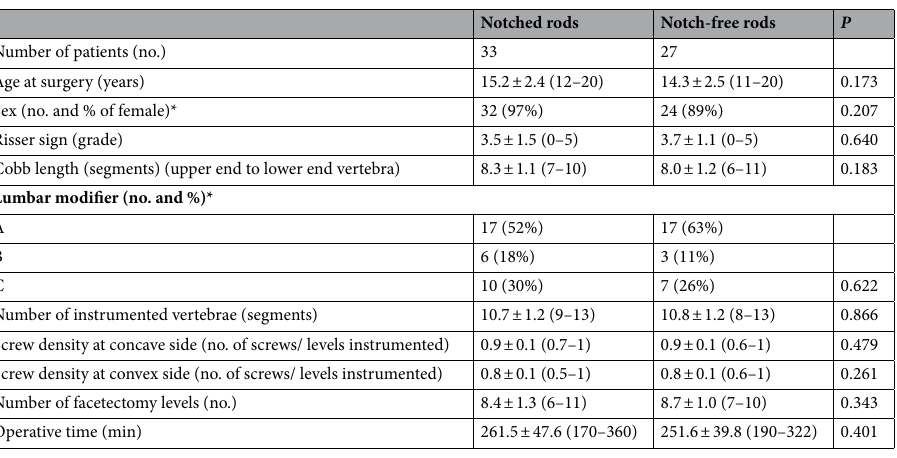
Table 1. Patient demographic data. All data expressed as means ± SD and range. Mann–Whitney U test or Chi-square test*.